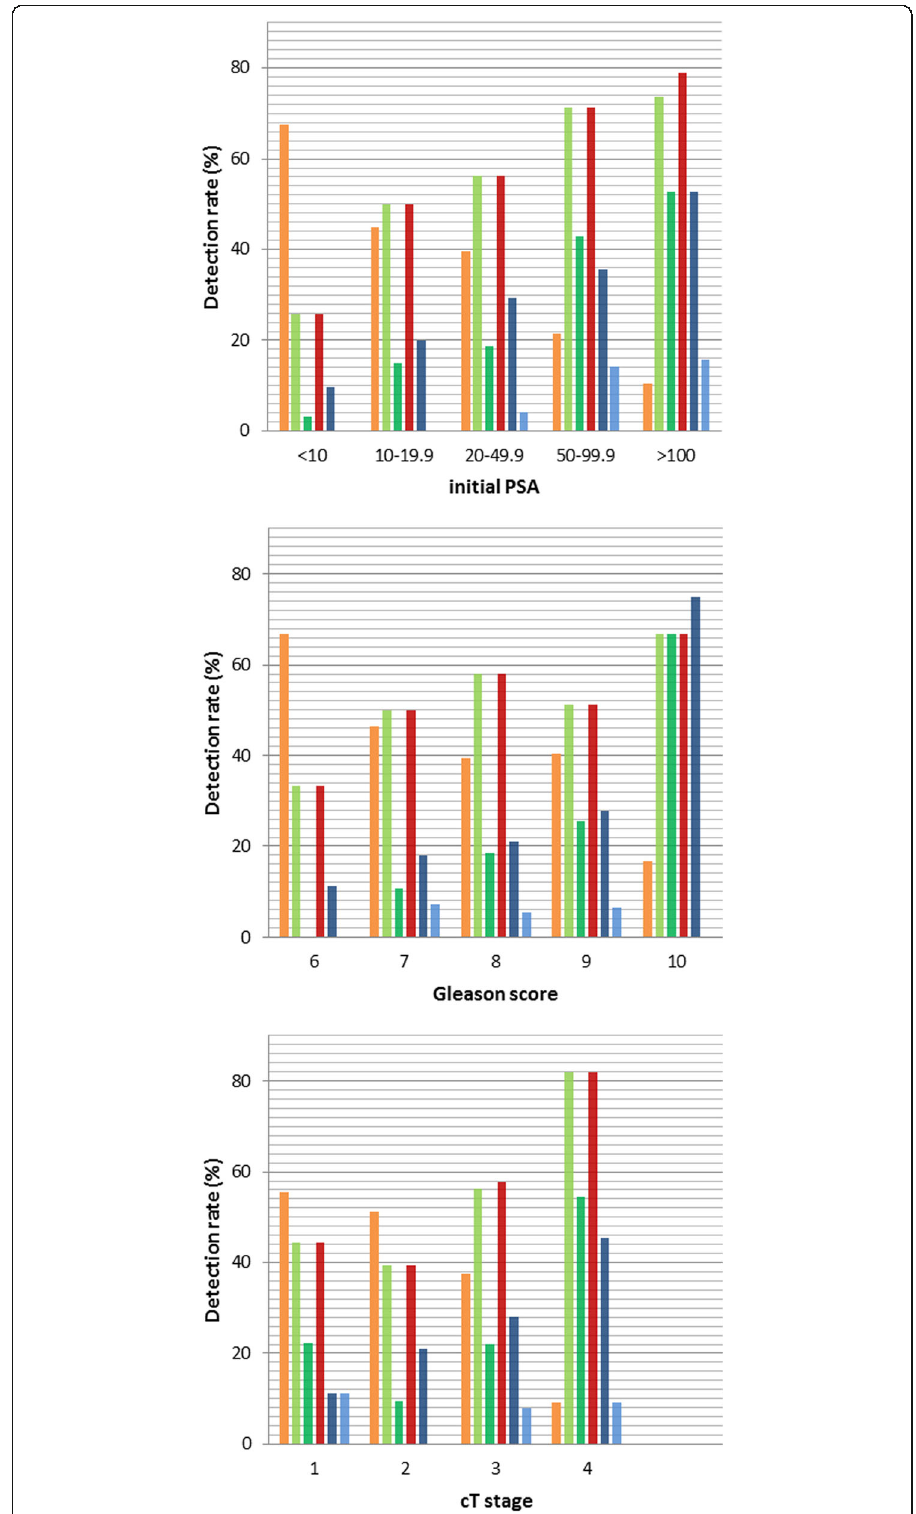
Fig. 2 (See legend on next